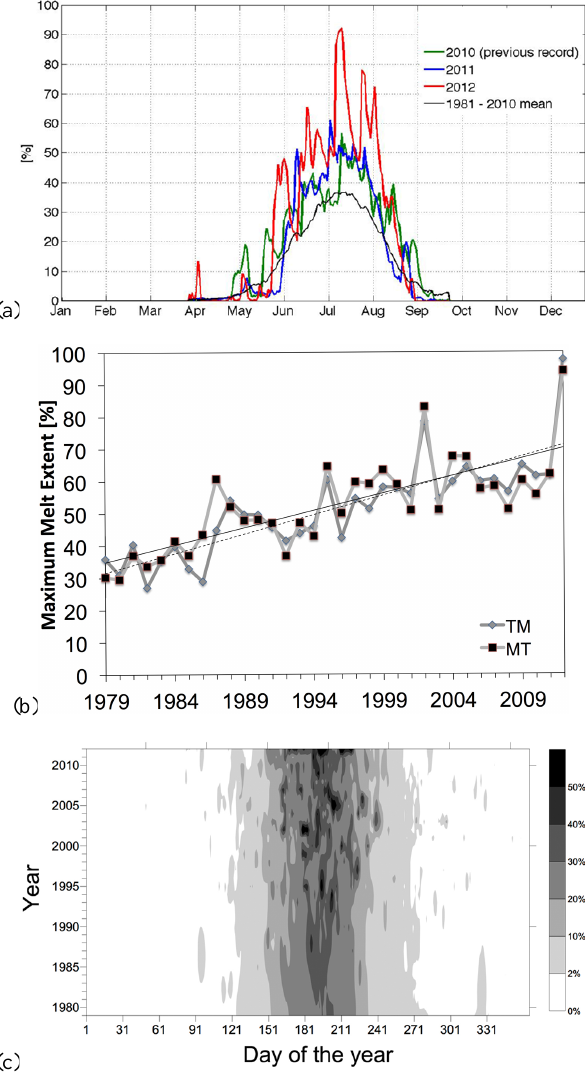
Fig. 2. (a) Melt extent (as a percentage of the Greenland ice sheet) time series derived from spaceborne passive microwave ob- servations using the algorithm in Tedesco (2009) in 2012 (red), in 2011 (blue), 2010 (green, being the previous record) and for the 1981–2010 mean (black). (b) Maximum melt extent for the period 1979–2012 using the algorithm in Mote and Anderson (1995), de- noted as TM, and in Tedesco (2009), denoted as MT. (c) Daily sim- ulated GrIS melt extent (in % of the ice sheet area) from January through December for 1979 through 2012 from passive microwave based on the algorithm given in Mote and Anderson